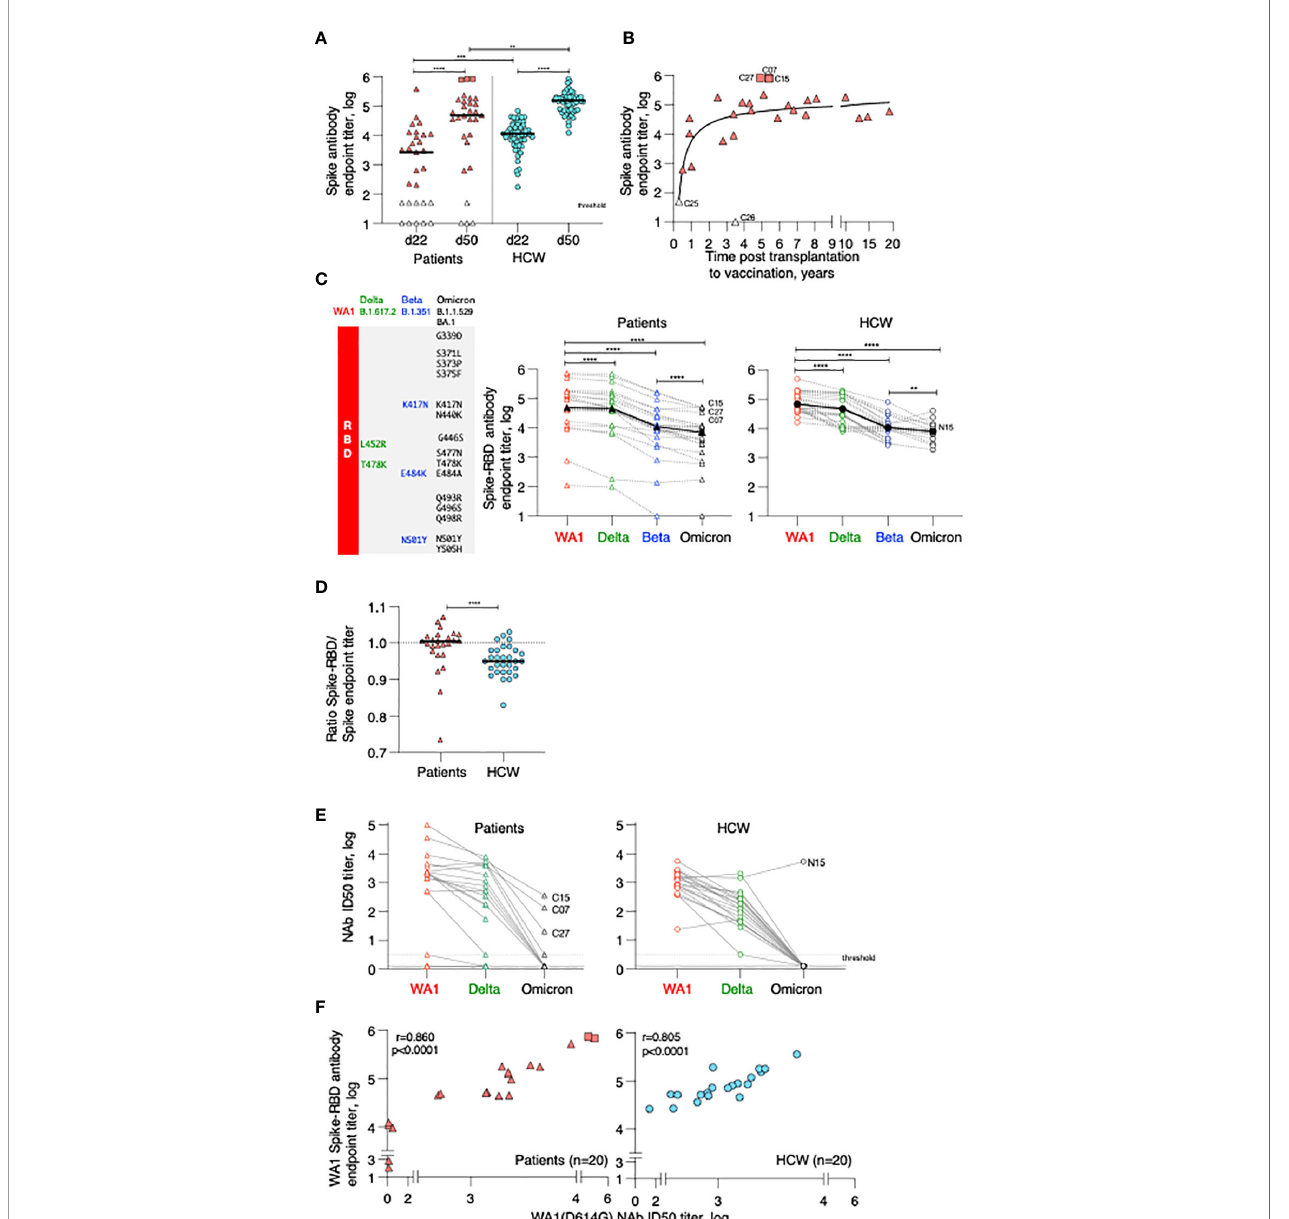
FIGURE 1 | Anti-Spike antibody in patients and control BNT162b2 mRNA vaccine recipients. (A) Endpoint titers (log) of wildtype Wuhan (WA1) Spike Ab measured by ELISA at d22 (day of 2 nd dose) and d50 post vaccination (one month later). The two cohorts are denoted as patient (triangle symbols; n = 29) and HCW vaccine recipients (circle symbols; n = 55, analyzed at both timepoints). Patients with high titers (C07, C15, C27; square symbols) and antibody-negative (open triangles: C16, C18) received CAR-T cells; C25, C26 received treatment affecting B cell development and function are indicated. A negative titer is entered as 1 log, a titer at the threshold of detection is entered as 1.7 log. The p values are from Wilcoxon test for same-group comparison and Mann-Whitney for comparison of the same timepoint between the two groups. (B) Association of anti-Spike Ab titers and time (years) between transplantation and vaccination (n = 27). (C) Cartoon illustrating amino acid changes in the Spike-Receptor Binding Domain (RBD) of the VOC Spike variants Delta, Beta and Omicron (left panel). Anti-Spike Ab endpoint titers measured by ELISA against the panel of Spike-RBD at d50 in the vaccinated patients (middle panel, n = 25) and in a subset of HCW (right panel; n = 30 with n = 19 for Omicron Spike-RBD). p values are from paired Wilcoxon test. Black solid symbols and line denotes median. (D) Ratio of Spike-RBD/Spike Ab titers of patients (n = 25) and HCW (n = 30) at d50. (E) Neutralization was performed using a pseudotyped HIV NL D Env-Nanoluc assay carrying a panel of Spike (AA 1 – 1254) proteins (WA1, Delta, Omicron). Infectious dose 50 (ID50) values are plotted in log. Patients were analyzed for WA1 and Delta (20 of 25, due to sample availability) and a subset of patients (n = 10) were further analyzed for Omicron (sample availability and/ or positivity for WA1 response). A subset of HCW was analyzed for WA1 and Delta (n = 20), of which 19, due to sample availability, were analyzed for Omicron. (F) Correlation of WA1(D614G) NAb ID50 titers (log) and WA1 anti-Spike-RBD endpoint titers (log) of patients (triangles) and HCW (circles) vaccine recipients at d50. Spearman r and p values are indicated. The p values are indicated as **, <0.01; ***, <0.001; ****,